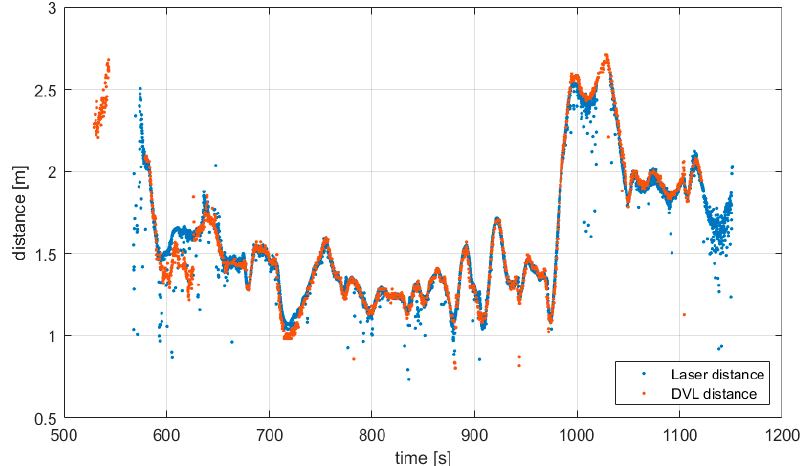
Figure 7. The doppler velocity log (DVL) distance measurement compared with the laser triangulation measurement.